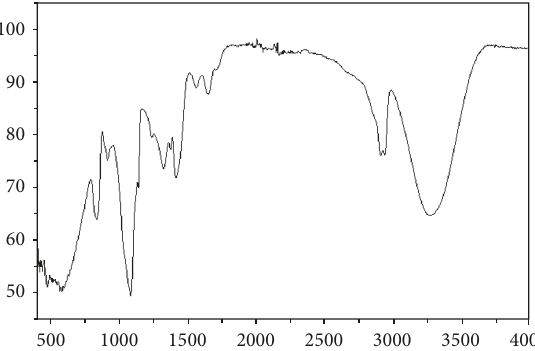
Figure 4: FT-IR spectrum of PLGA-CS